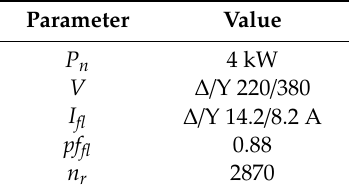
Table 20. Data of Machine 5 [46].